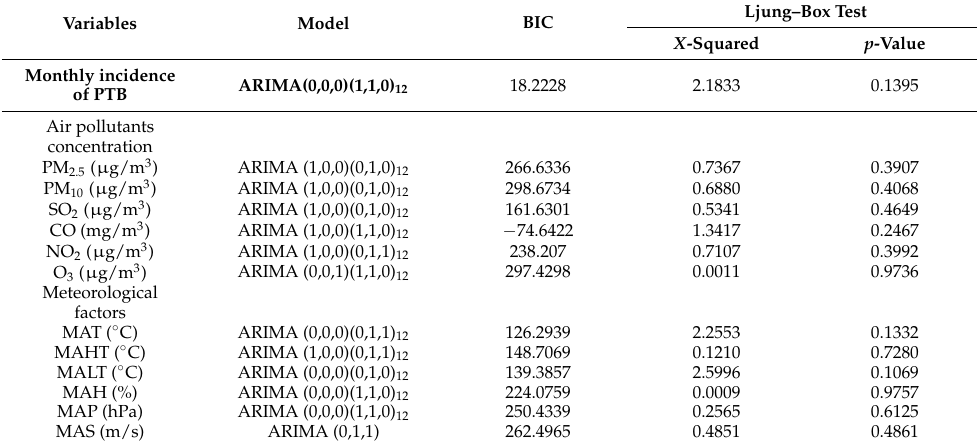
Figure 1. Time series of the monthly incidence of PTB, the monthly average air pollutants concentra- tion, and meteorological factors in Ningbo from 2015 to 2019. Table 2. The optimal ARIMA model for monthly incidence of PTB, the monthly average air pollutants concentration, and meteorological factors in Ningbo from 2015 to